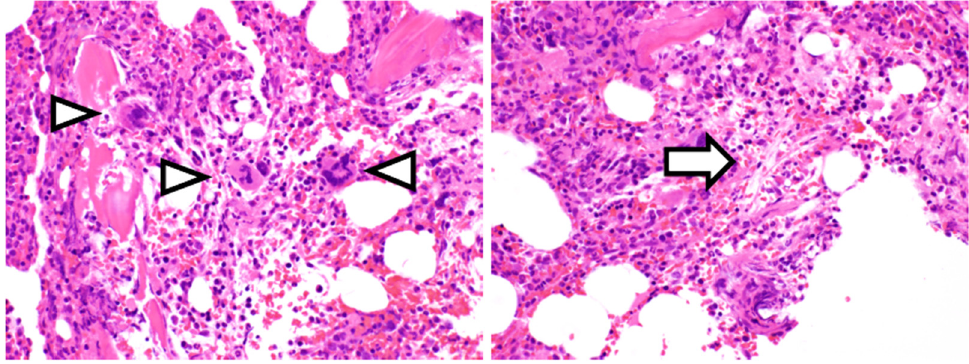
Figure 2. Bone marrow lesions in our patient. Hematoxylin and eosin staining shows a hypercellular marrow with megakaryocyte clusters (arrowheads) and mild reticulin fibrosis (arrow) (×200).